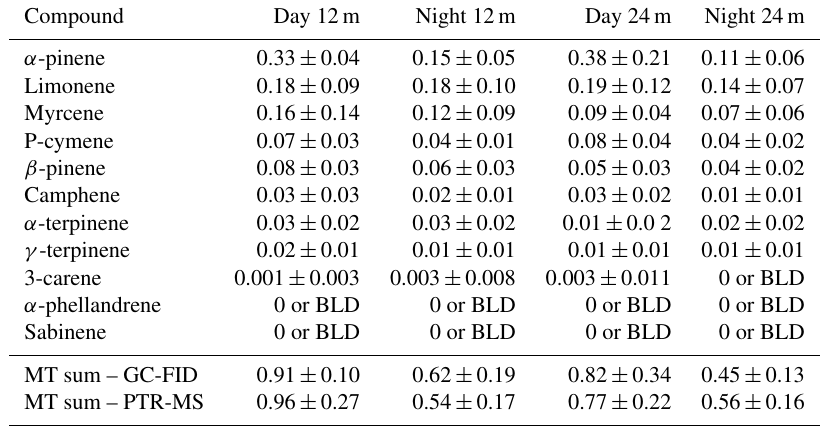
Table 1. Average mixing ratio with standard deviation in ppb at 24 and 12m of the measured monoterpene species from 17 to 20 October 2015 as determined by the GC-FID analysis. The daytime period was chosen from 09:00 to 17:00 and the night-time period from 20:00